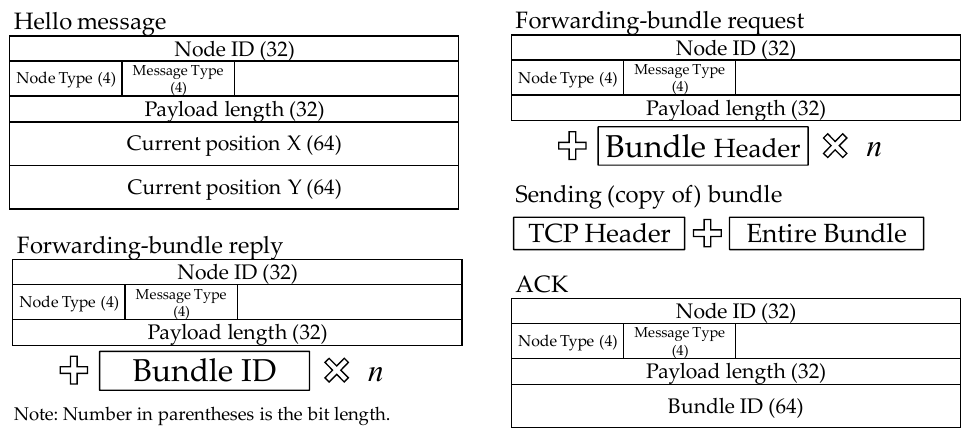
Figure 12. Structures of the messages exchanged between the sending node and a relay node.